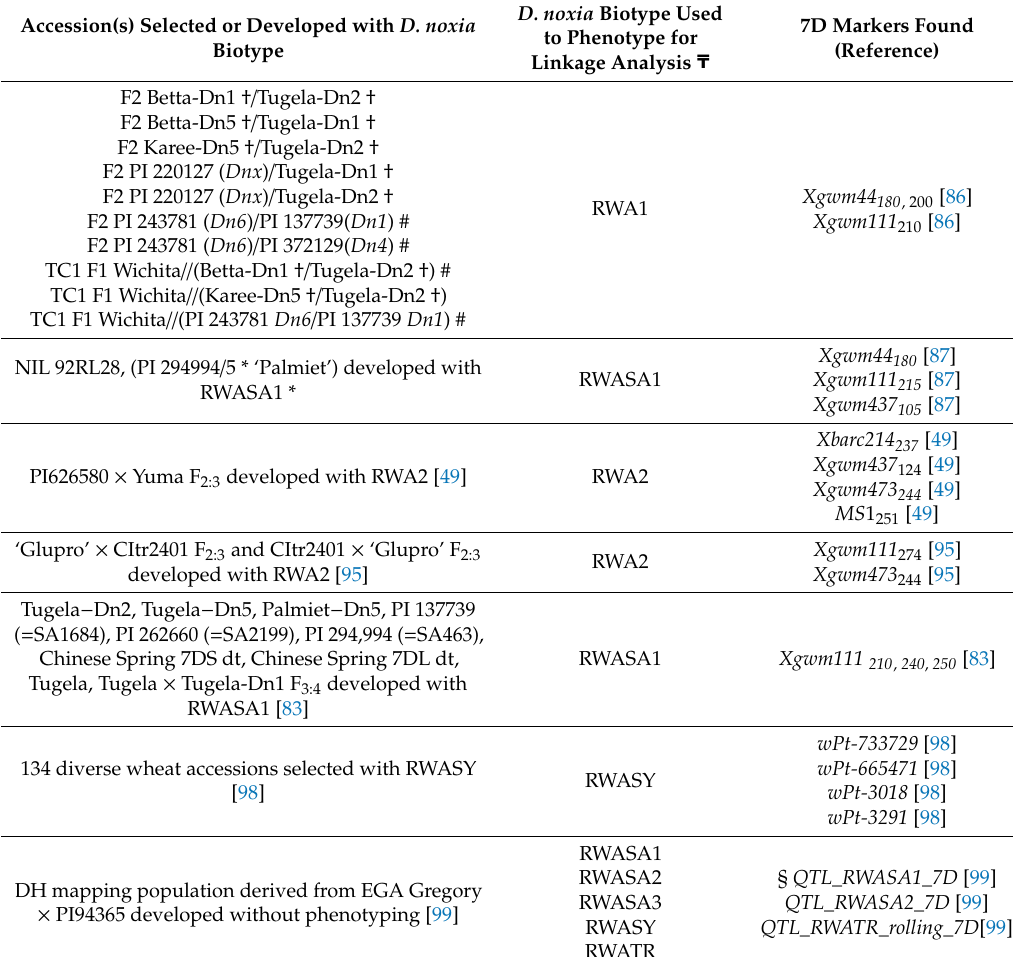
Table 4. Biotype(s) used for selection and/or development of wheat accessions, for the linkage analysis phenotyping and 7D marker alleles reported in the literature.